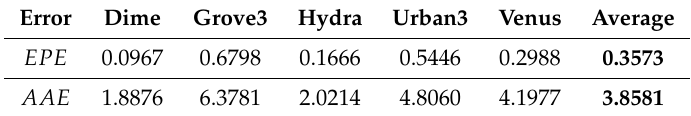
Table 9. Average EPE and AAE obtained by Random Location Strategy in VALIDATION_SET set.